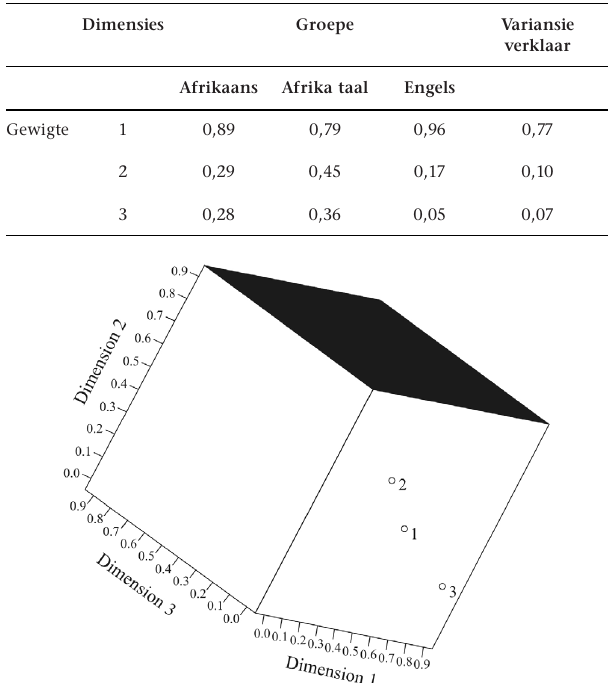
Figuur 2: Grafiese voorstelling van die afstand tussen die drie taalgroepe na verwydering van DIF items (1 = Afrikaans, 2 = Afrika taal, 3 =